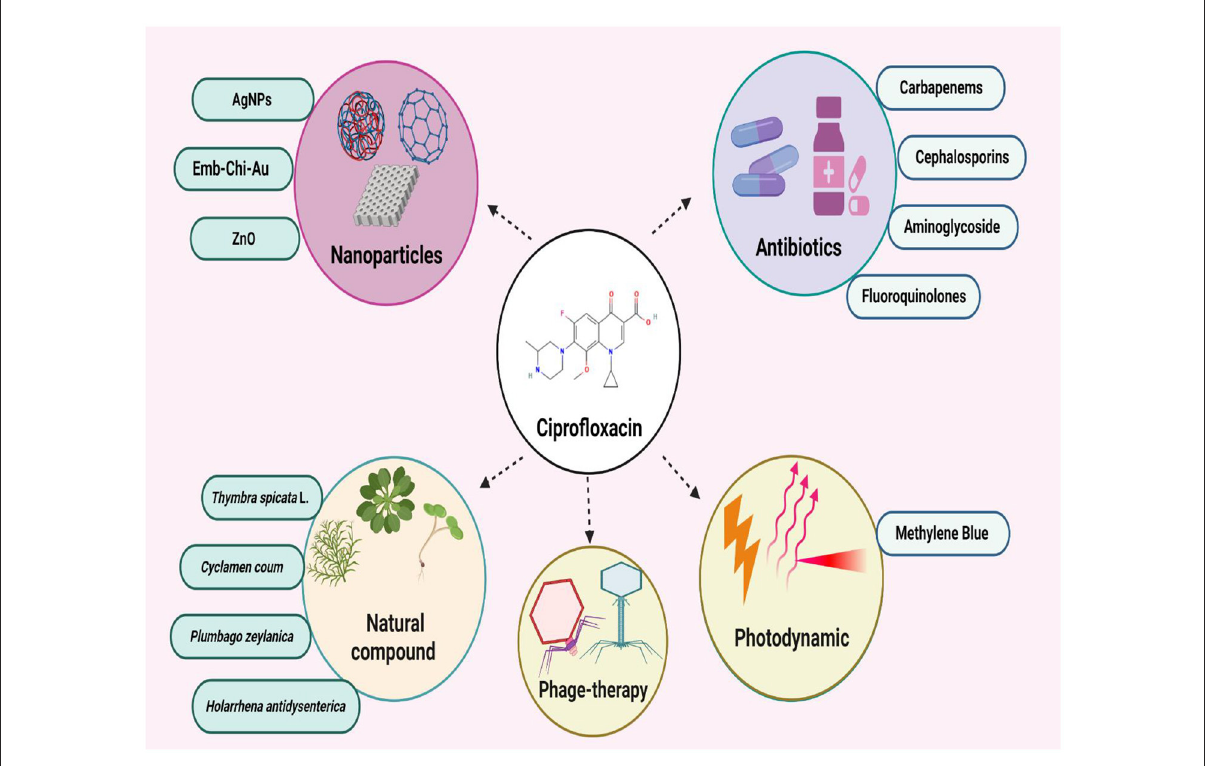
FIGURE5 The combination uses ciprofloxacin and other antibacterial